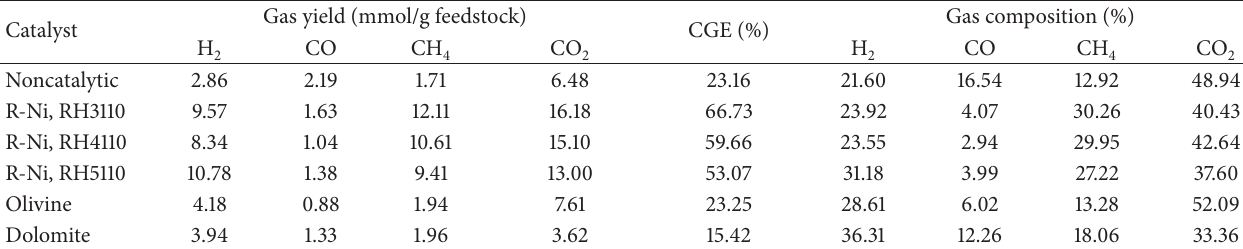
Table 6: Experimental results for different heterogeneous catalysts.